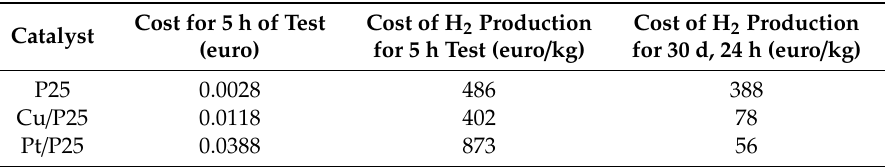
Table 3. Cost referred to one kilogram of produced hydrogen for a single 5 h test or assuming continuous production for 30